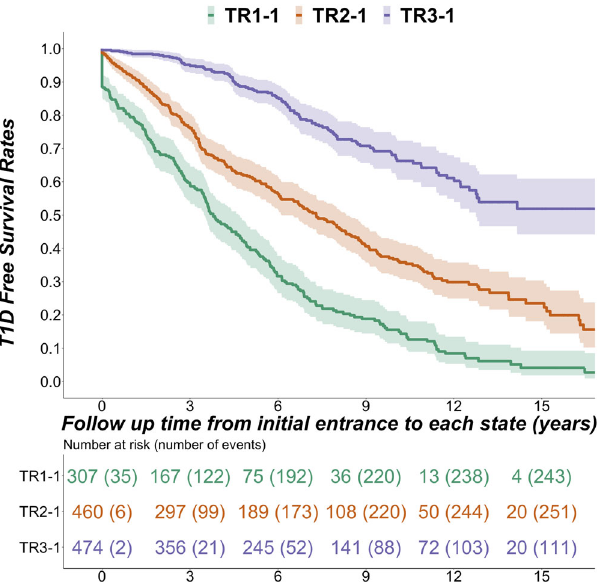
Fig. 4 Diabetes-free survival strati fi ed by the three trajectories. T1D-free survival curves (mean and 95% con fi dence interval) of the three trajectories starting at fi rst entry into IAb positive state (TR1-1, green; TR2- 1, red; TR3-1, purple). Source data are provided as a Source Data fi